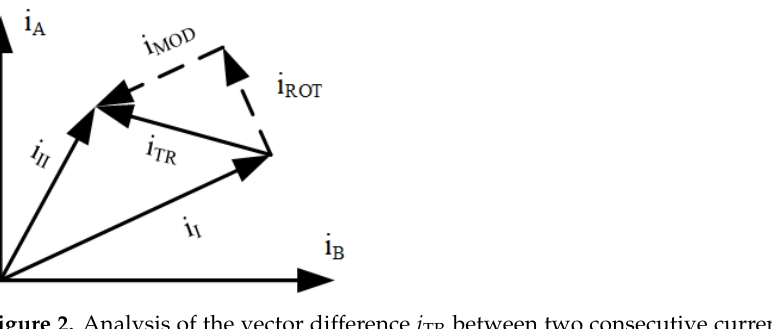
Figure 2. Analysis of the vector difference i TR between two consecutive current phasors i I and i II . Incremental torque corresponds with rejection of i TR onto i I denoted by i ROT . Signal curvature is then defined by projection i MOD